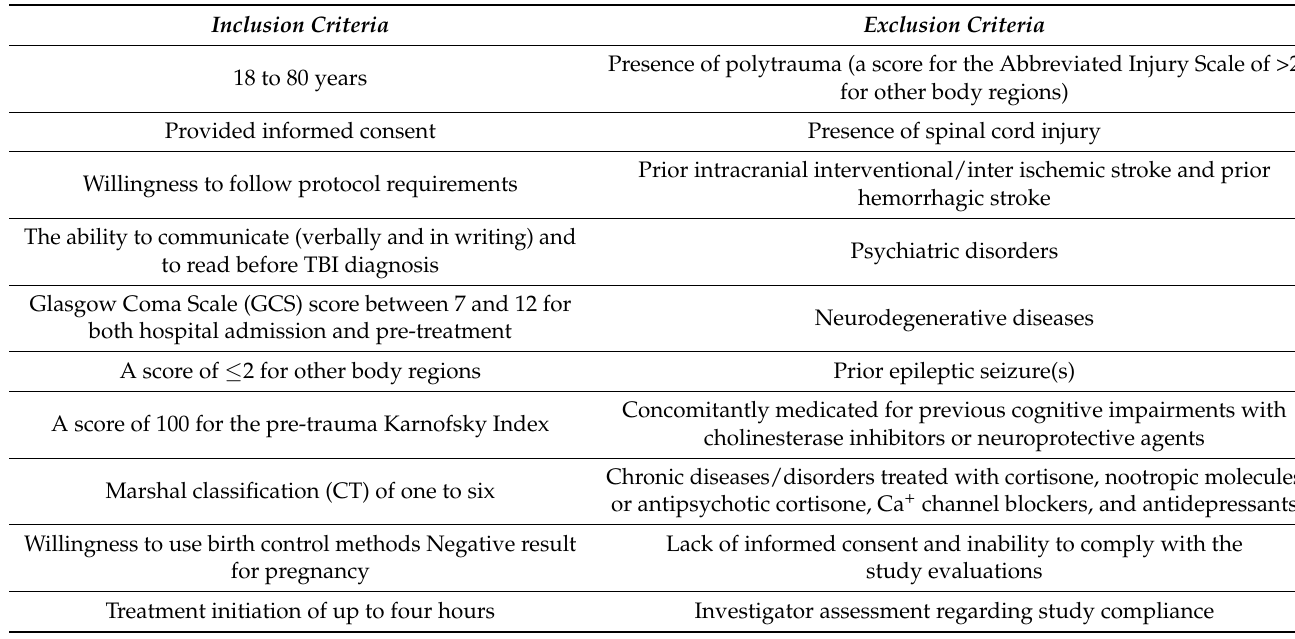
Table 1. Inclusion and exclusion criteria for CAPTAIN—II trial.